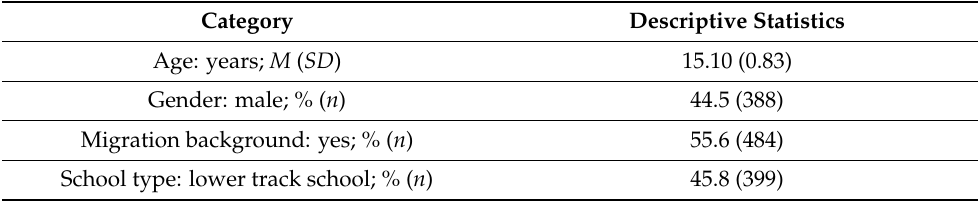
Table 1. Participant characteristics of the youth cohort (t1–t2, two-wave panel, N =